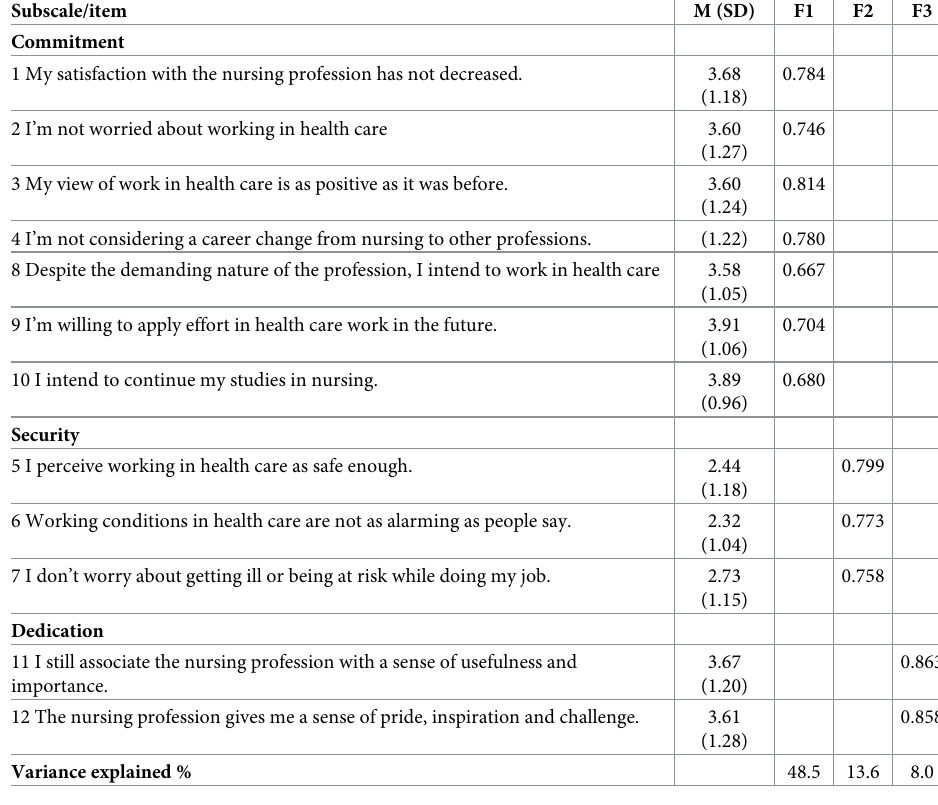
Table 2. Descriptive statistics and factor loadings for the students’ attitudes toward nursing profession scale.